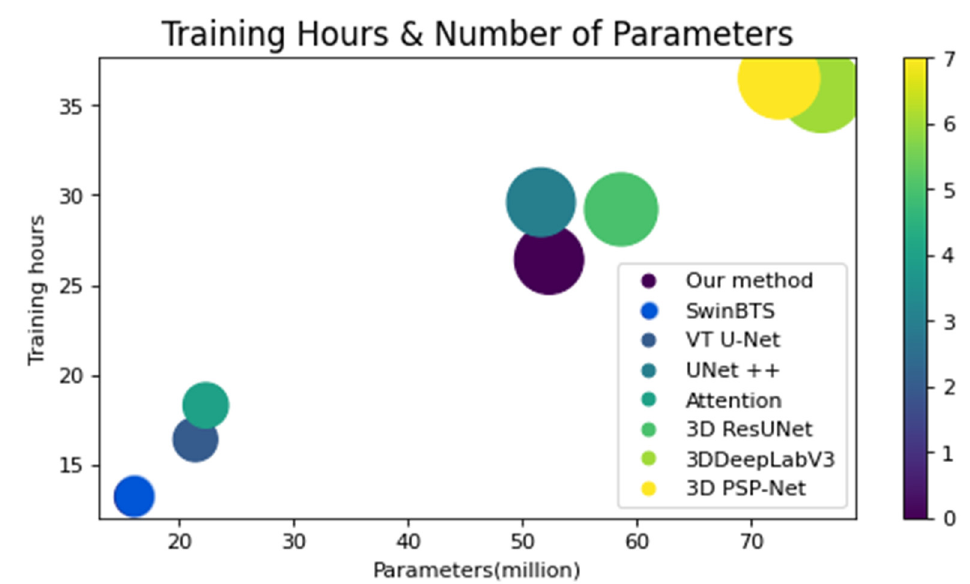
Figure 9. Comparison of Dice score and the number of parameters.